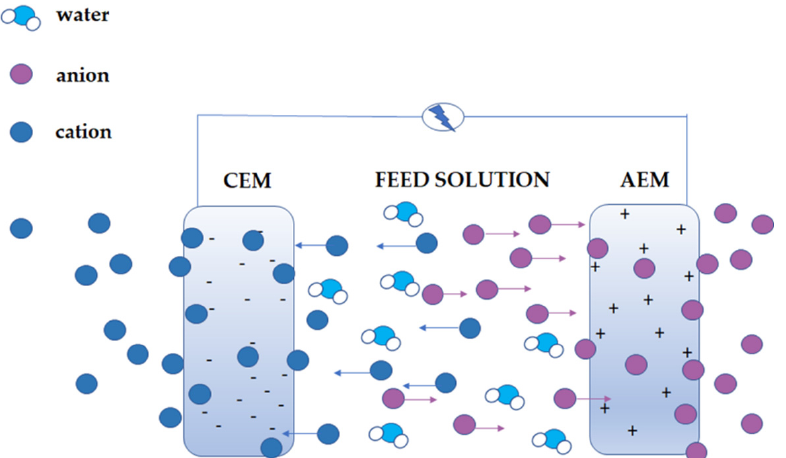
Figure 1. Ion-exchange membranes are used in processes such as electrodialysis that utilises an electric potential difference ( Δ V) and allows passage of counter-ions (blue spheres in the case of CEM or Purple spehres in the case of AEM) while hindering co-ions (purple spheres in the case of CEM or blue spehres in the case of AEM) and water.